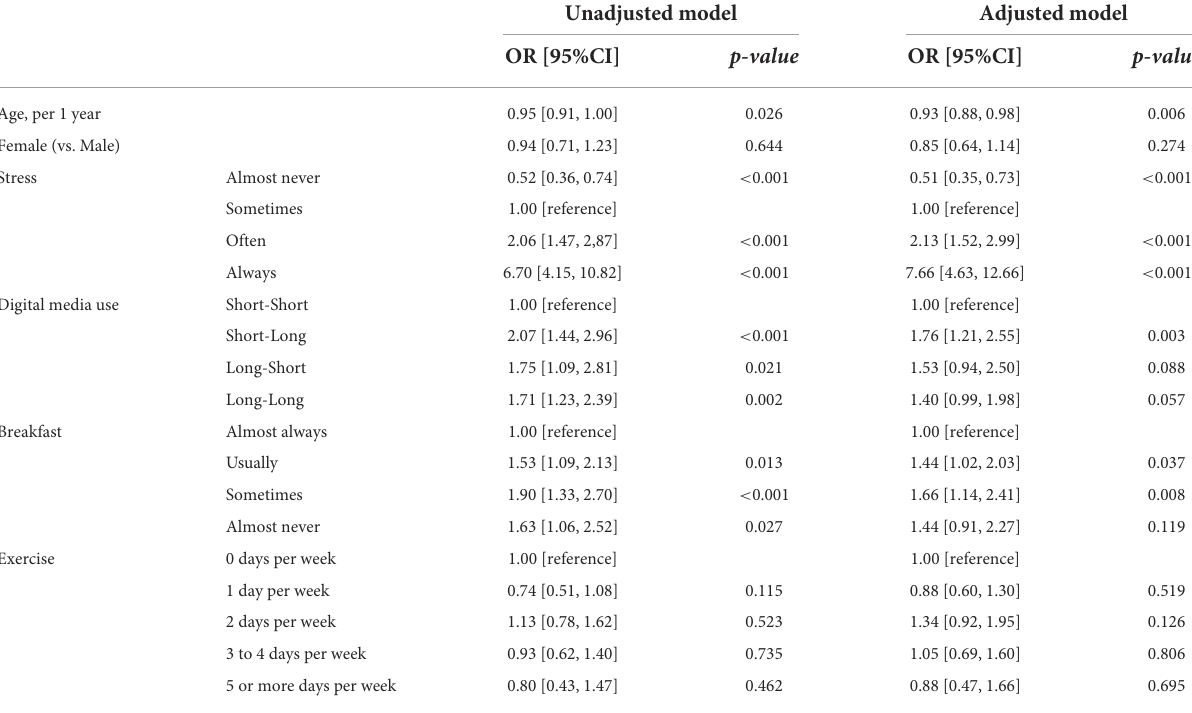
TABLE 2 The association between the incidence of sleep problems and changes in digital media use from 2019 to